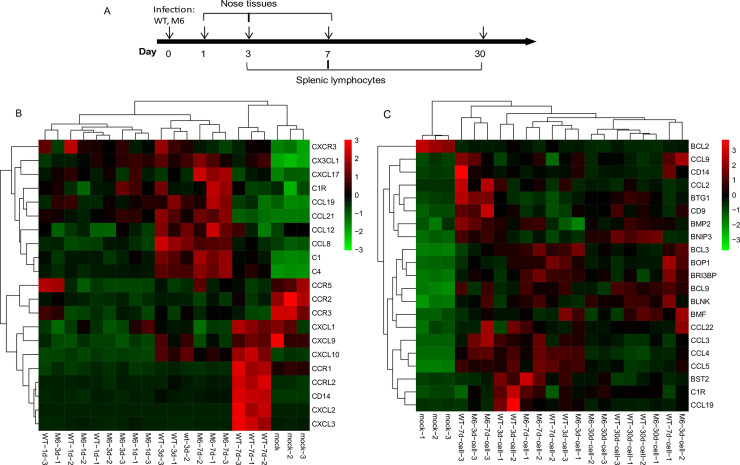
The immune responses induced by WT or M6 virus in mice by transcript omics analysis.(A) Flow charts for sample collection for transcript omics analysis. Genes with significantly upregulated or downregulated expression in nasal tissues (B) or splenic lymphocytes (C) and linked to IFN-γ by INTERFEROME analysis.